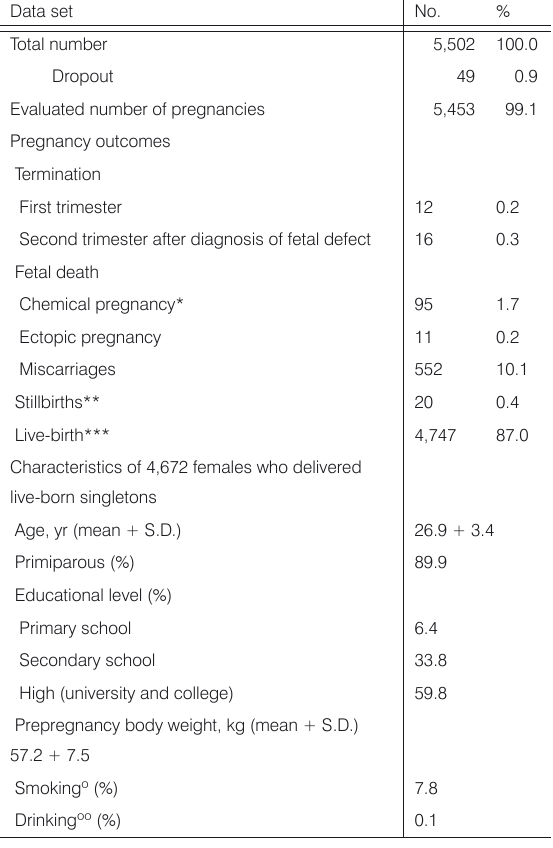
preconceptional care with known clinical diagnosis